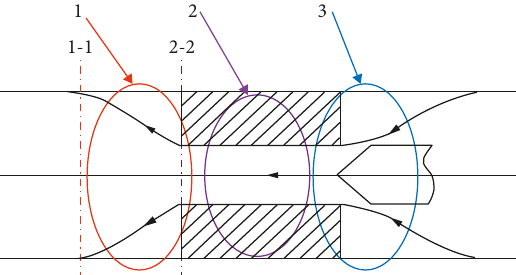
Figure 3: Energy losses of digital damping unit. (1) Local pressure losses at sudden change cross section; (2) friction pressure losses through the orifice; (3) local pressure losses through the cone valve